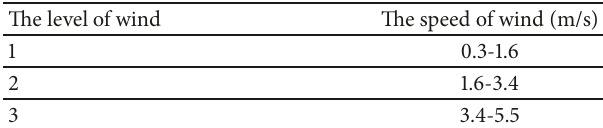
Table 2: The relationship between the level of wind and speed of